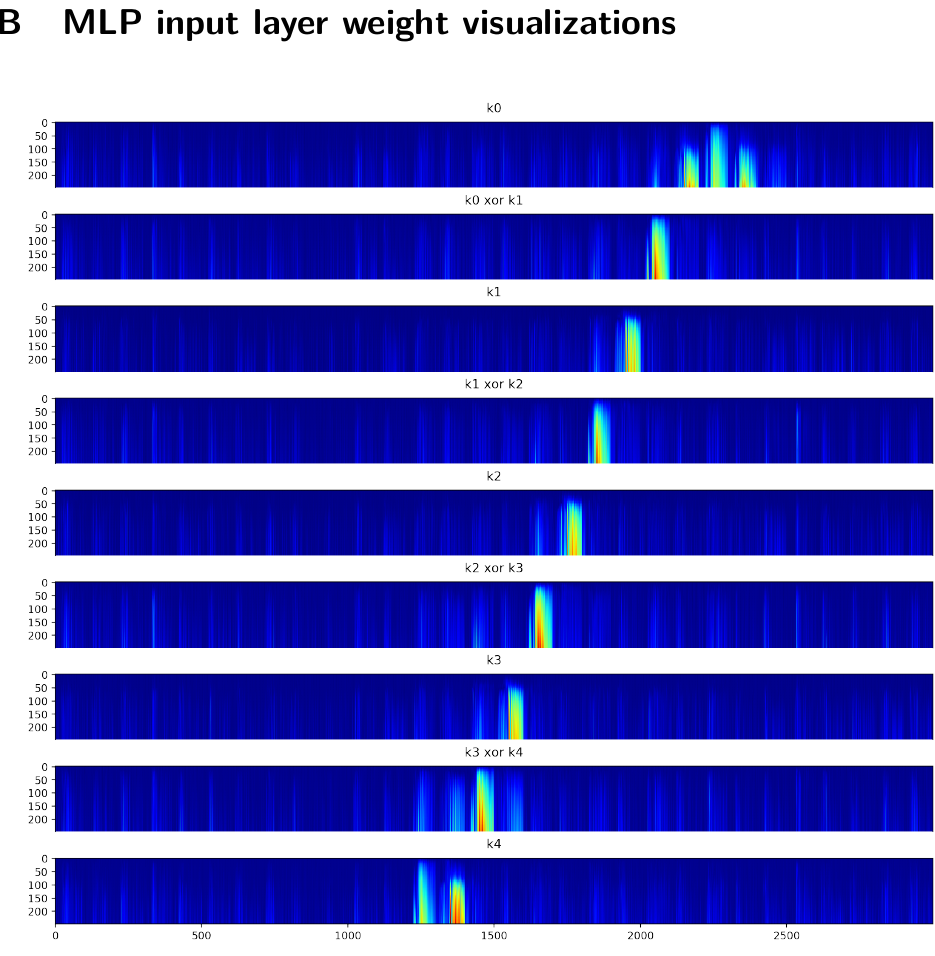
Figure 9: L ∞ norm of the input weights over the 250 training epochs (y-axis) for models trained on a single